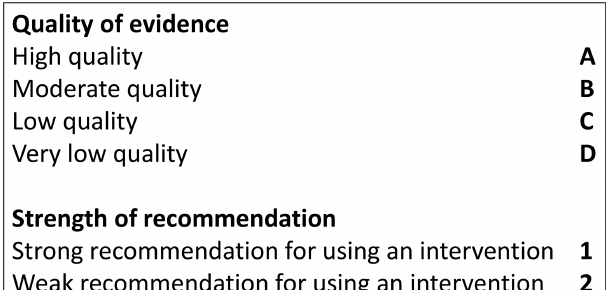
Figure 1. Representations of quality of evidence and strength of recommendations (Guyatt et al.,